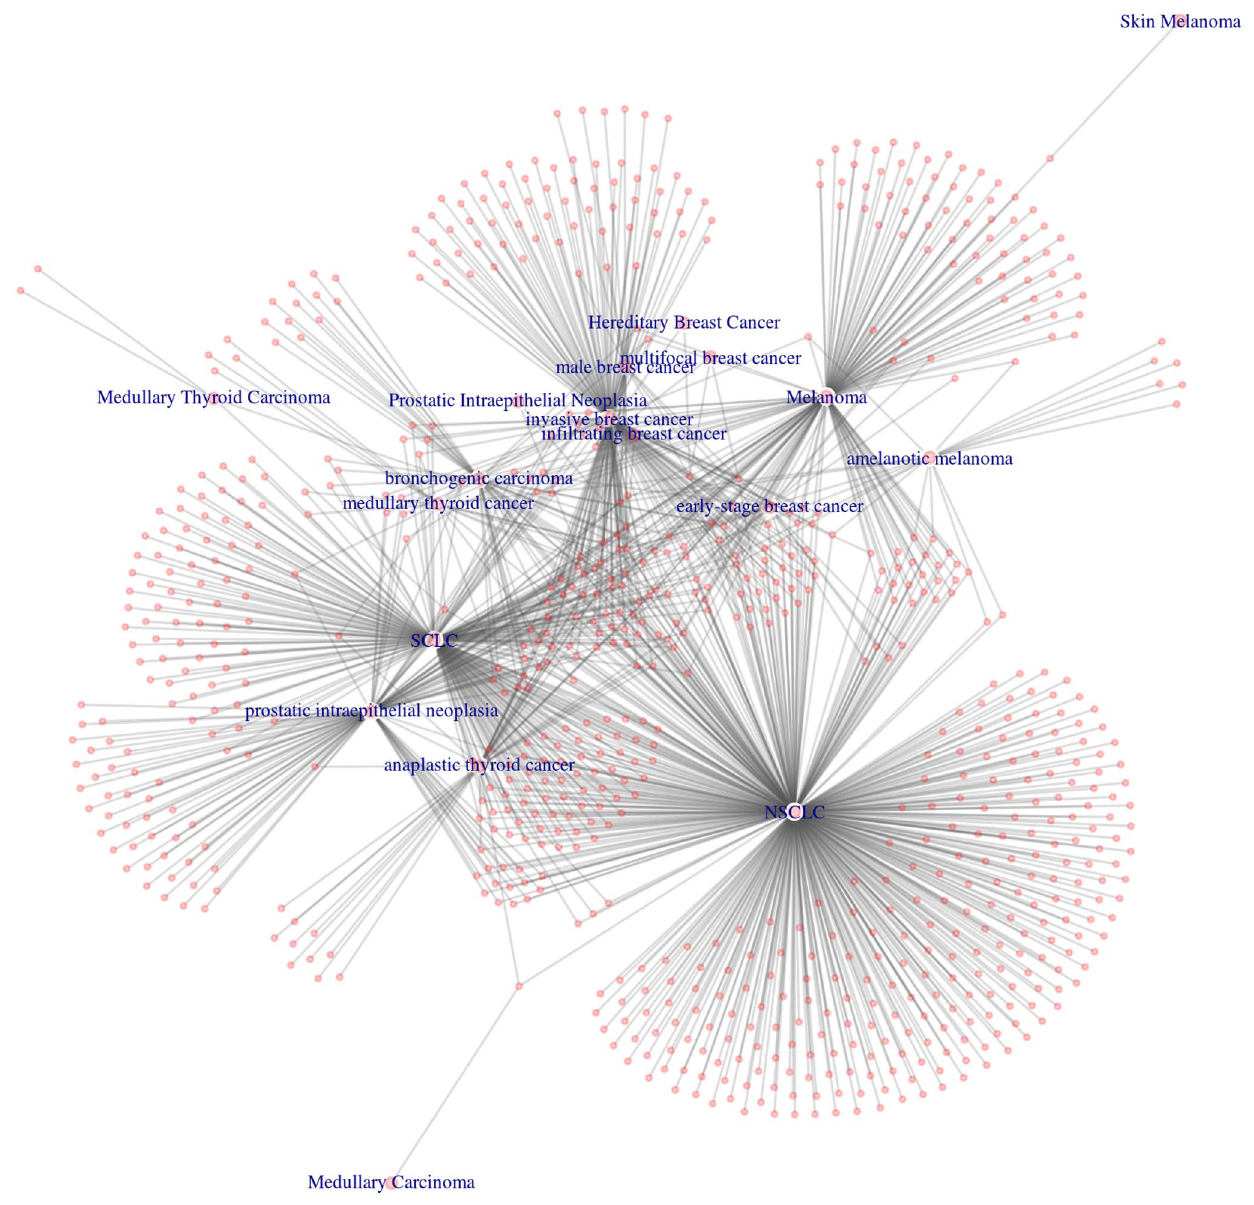
Figure 3. Network of Cancer-Gene associations from literature. Network of Cancer/Gene associations displaying shared genes between cancers and genes specific to certain cancer types based on literature evidence. Cancer terms are represented as labeled nodes, genes are unlabeled pink nodes and the edges represent at least one publication with a co-occurrence of the cancer term and gene.